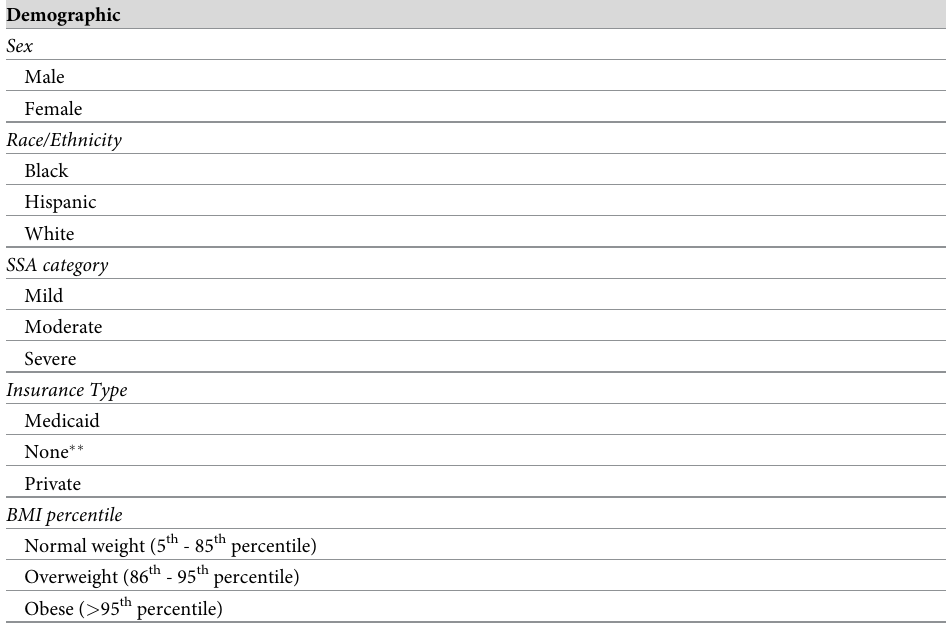
Table 1. SCFE patient demographics and clinical characteristics summary.